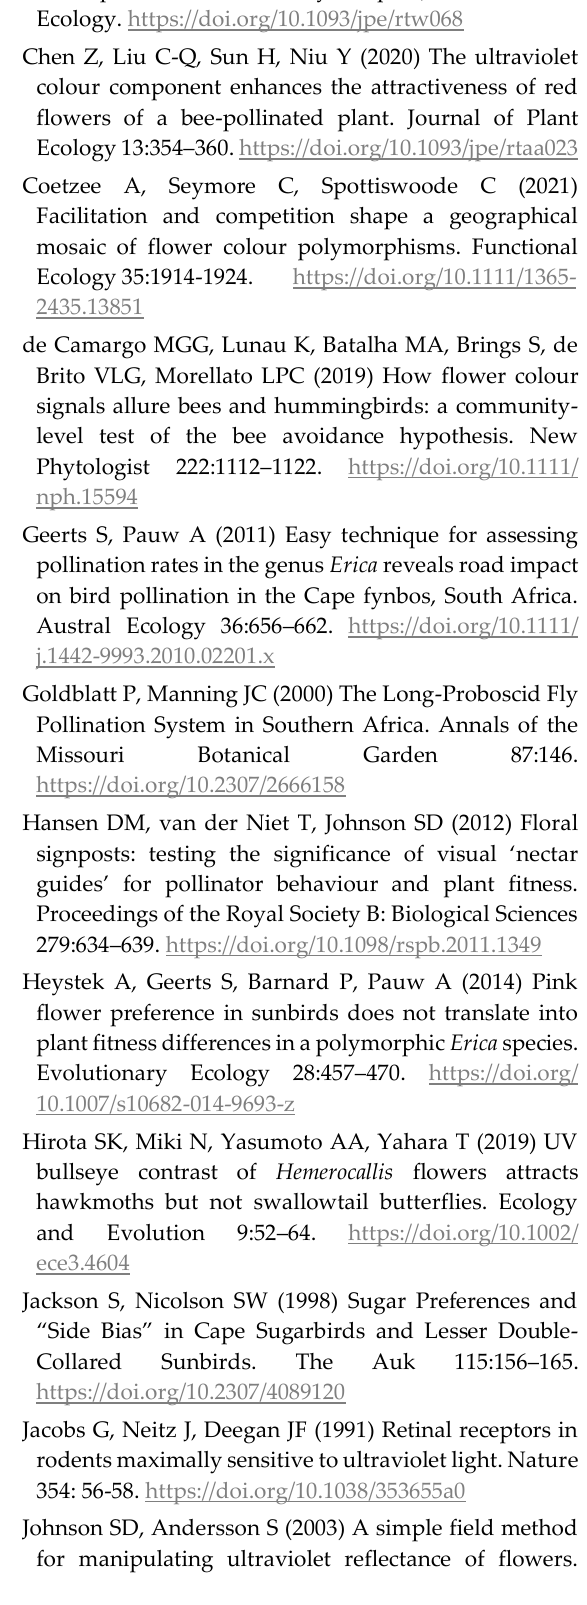
Table S5. Average number of seeds per treatment. Output from generalised linear model. Table S6. Average number of seeds per treatment. Output from Kruskal-Wallis post-hoc test. Figure S1. Spectral reflectance of A) White non-UV model flower and B) White UV model flower. Figure S2. Spectral reflectance of A) Pink non-UV model flower and B) Pink UV model flower. Figure S3. Spectral reflectance of A) E. aristata after treatment with sunscreen and B) untreated E. aristata flowers. Figure S4. Treated and untreated flowers of E. aristata are different according to the Troje fly colour